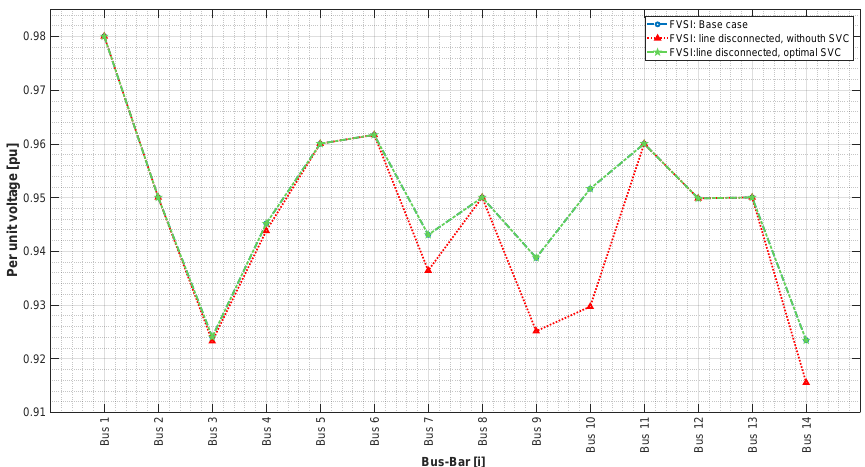
Figure 8. First study case: Voltage profiles before/after contingencies and with SVC compensation, when the weakest line is disconnected.